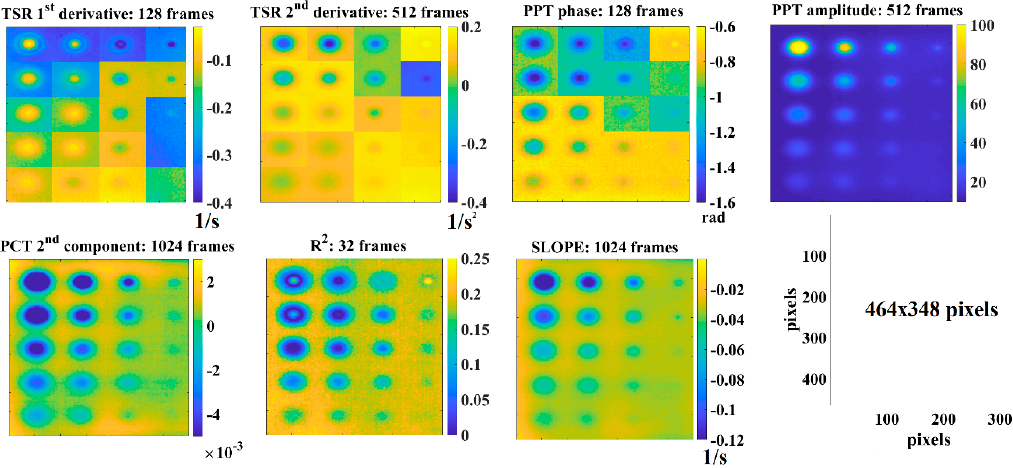
Figure 22. Best maps for each algorithm and for the intervals for which the greatest number of defects were detected. Table 6. Final comparison among the different